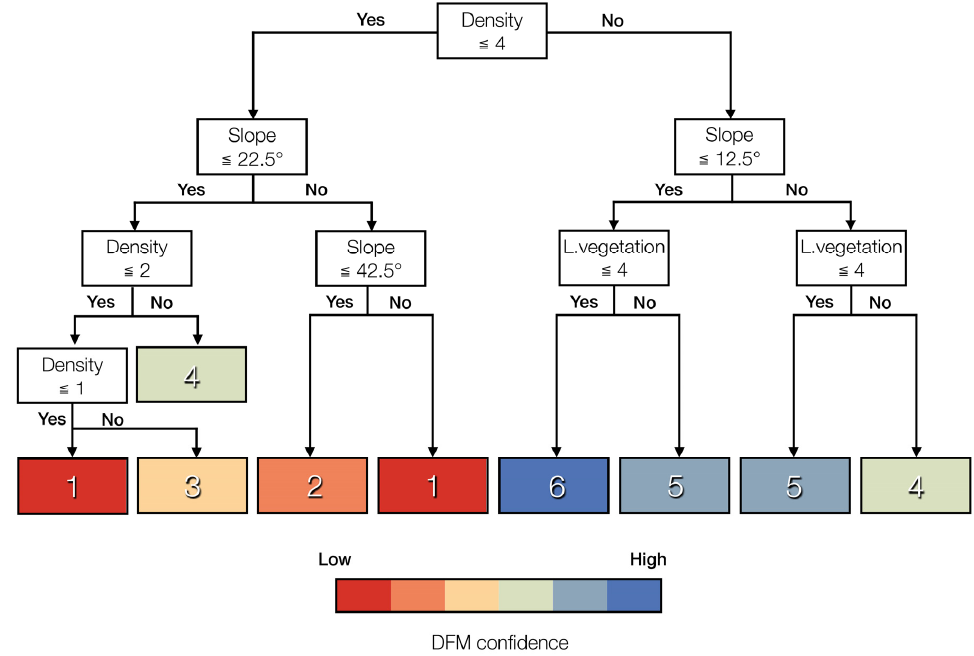
Figure 3. Classification tree resulting from a CART analysis of absolute errors for 0.5 m DFM. The model is read from top to bottom until the terminal nodes, which predict the confidence level of the selected variables (one: lowest confidence; six: highest